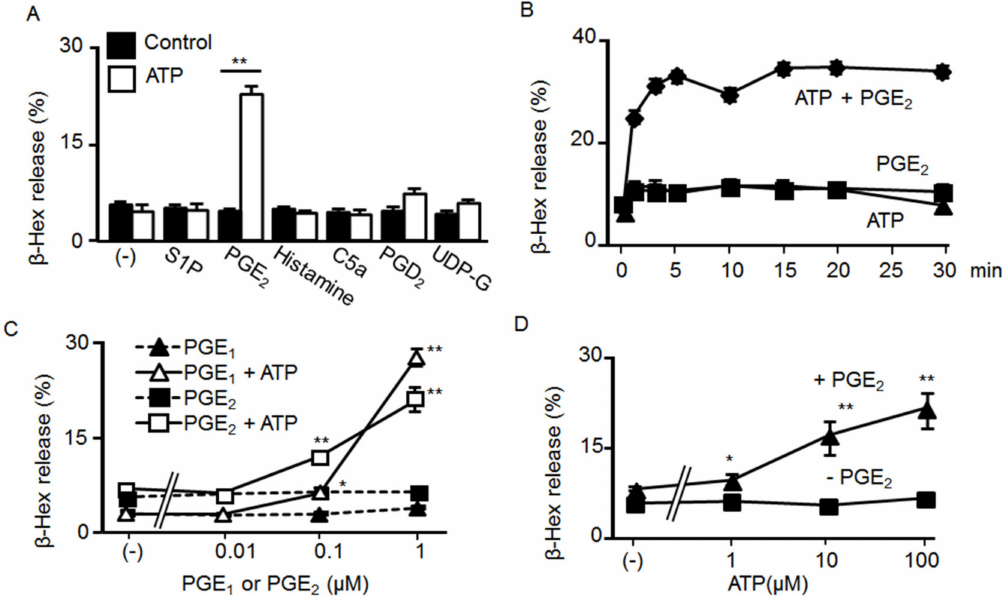
Figure 1. Synergistic e ff ects of ATP and prostaglandin (PG)E 2 on mast cell (MC) degranulation. ( A ) Bone marrow-derived MCs (BMMCs) were stimulated with sphingosine-1-phosphate (S1P) (1 µ M), PGE 2 (1 µ M), histamine (100 µ M), C5a (10 nM), PGD 2 (1 µ M), and UDP-glucose (100 µ M) with or without